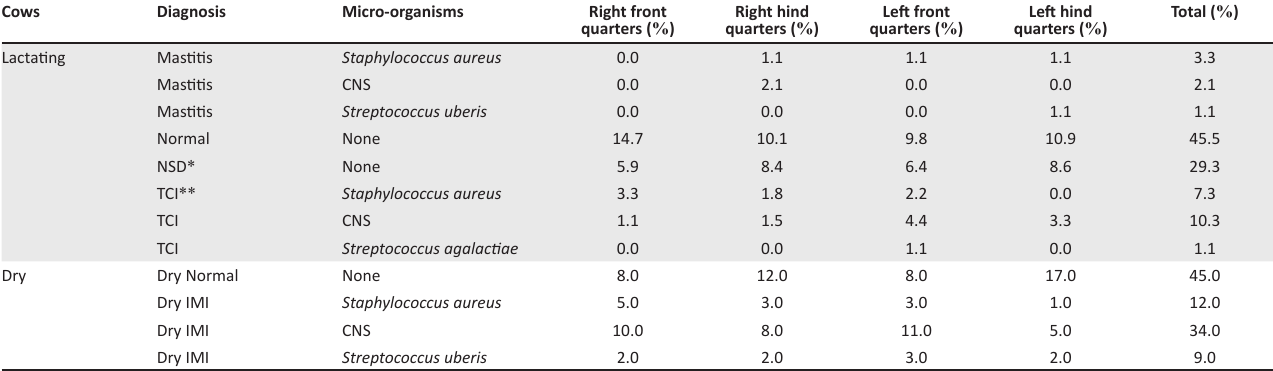
TABLE 3: Current Herd Udder Health Report based on somatic cell count and culture results of quarter milk samples from lactating and dry cows. Cows